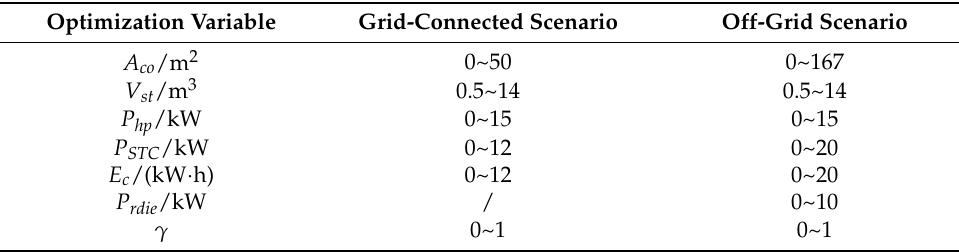
Table 3. Ranges of optimization variables.